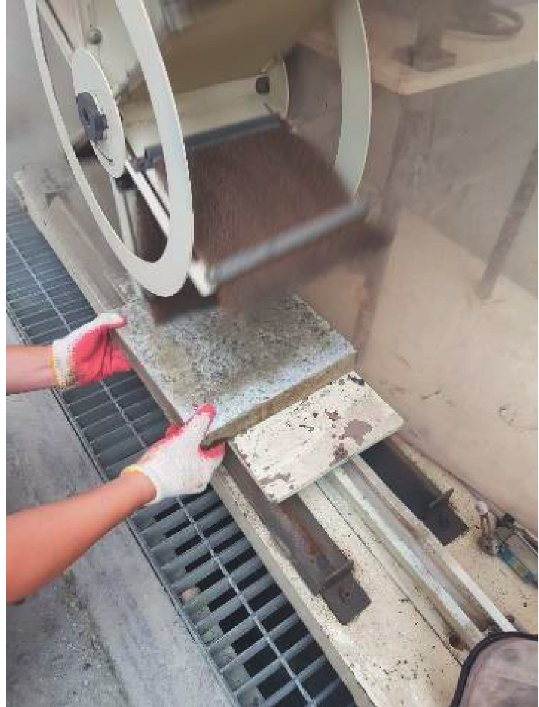
Figure 6: Aggregate exposure by steel brush in the laboratory.